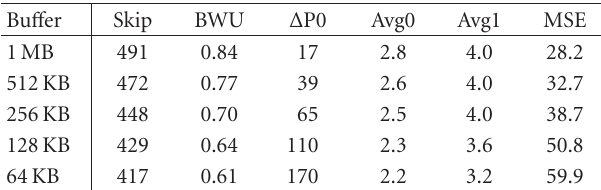
Table 2: Experimental results comparing ARC + W(4) + Skip(7) with various bu ff er sizes.